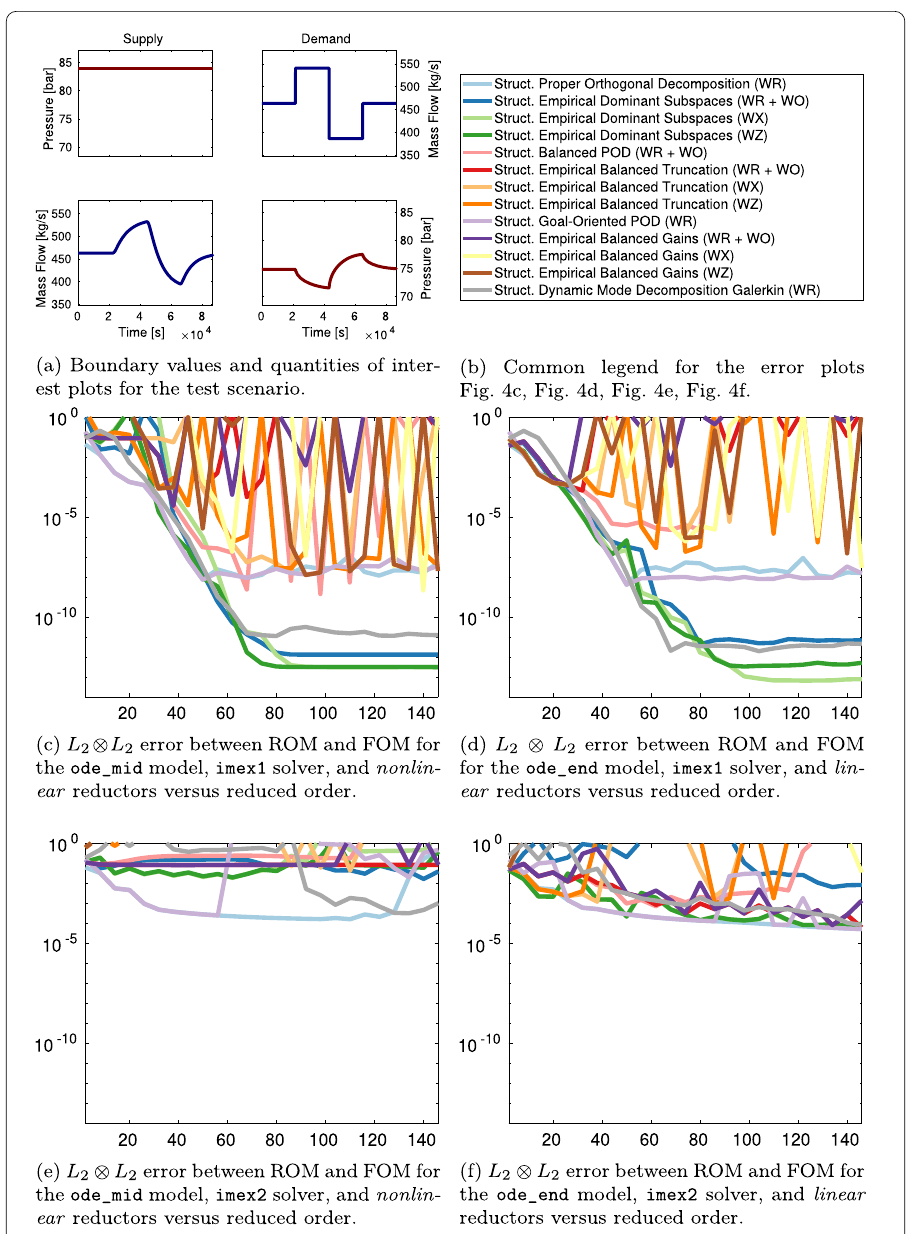
Figure 4 Visualization of the test scenario, and model reduction errors of the tested ROMs for the Yamal-Europe pipeline from Sect.